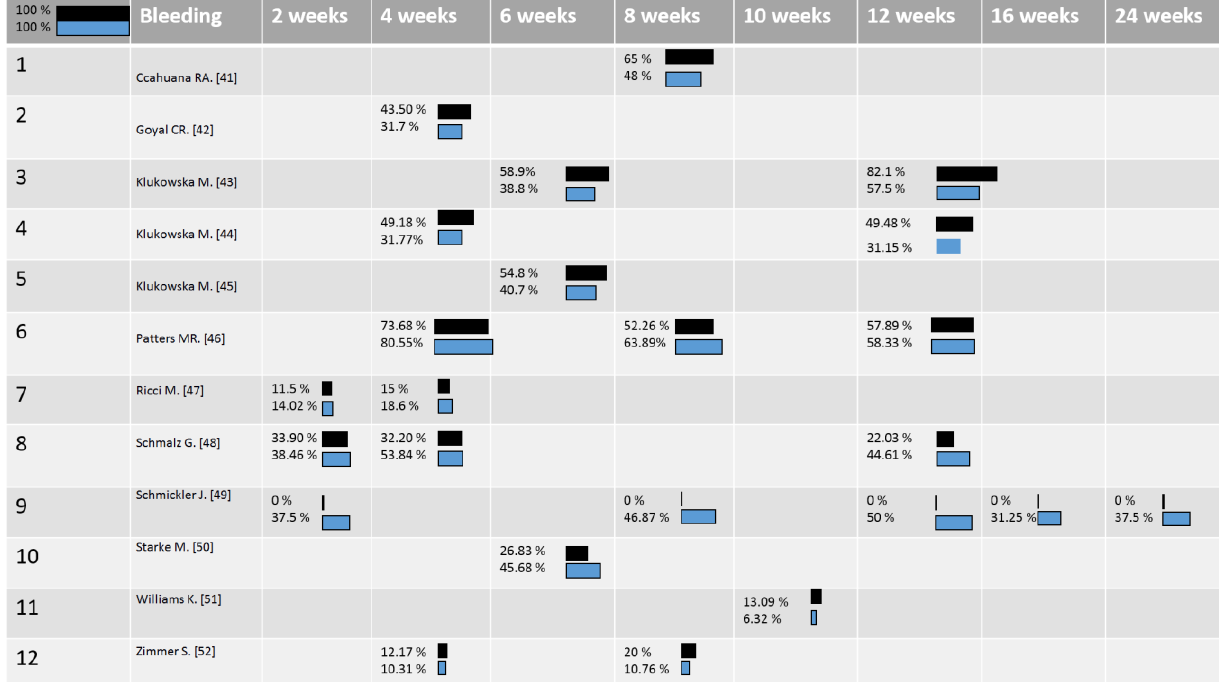
Figure 3. Bleeding Index, the mean values of Bleeding Index (changes) in relation to the number of patients in each study at each time-point: blue color corresponds to ORHs and black to SAHs toothbrushes [41–52].